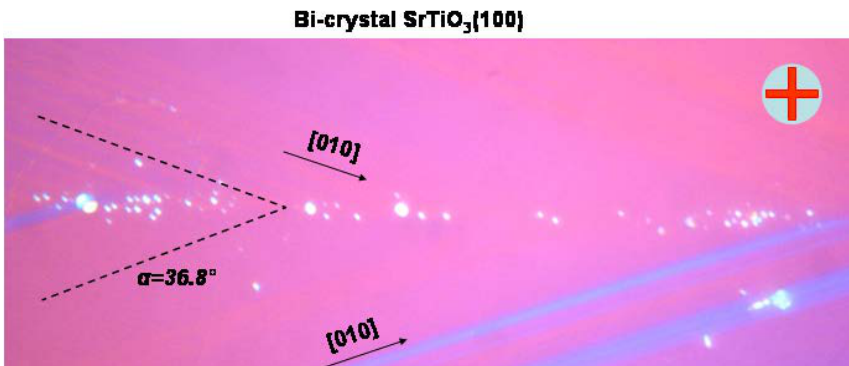
Figure 56. Creation of bubbles on the anode (30 nm-Pt thin film) of a SrTiO 3 (100) bicrystal during electrodegradation. It should be mentioned that along such a boundary a broad band of the dislocations and dislocation bundles has been found (see Figures 12–16). Notice: a simple identification of the tilting angles of both parts of the bicrystal on the non-transparent Pt electrode is an effect of the plastic deformation of the electrode which leads to the interference contrast. A participation of an array of dislocations or their bundles (agglomerated along a bicrystalline boundary) can not only be identified for electro-migration processes, but the self-diffusion of oxygen in bicrystalline SrTiO 3 at high temperatures is similar in character. An illustration of a selective incorporation of 18 O isotope (under equilibrium condition) is given in Figure 58, where the exchange of isotopes takes place preferentially along the boundary as well as in regions with a high concentration of dislocations originating from local mechanical damage [259].